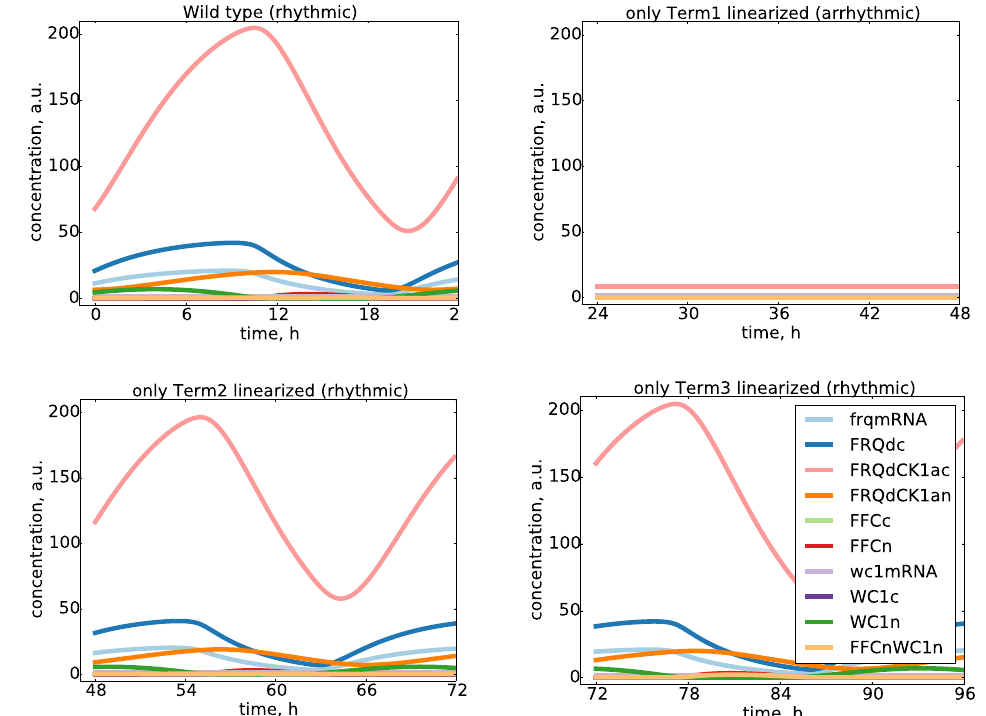
Figure A4. Essential and non-essential nonlinearities in the model: We linearized all three nonlinear terms and found that the Hill function of frq production (Term1) was essential, whereas the positive feedback nonlinearity (Term2) and the bilinear dimerization (Term3) were not essential since linearizations kept the rhythmicity.